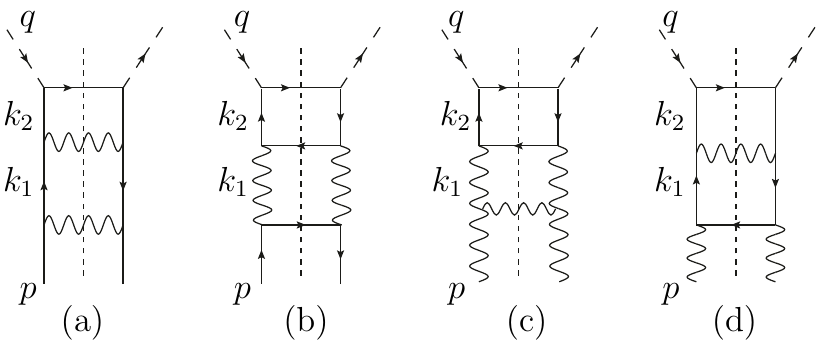
Figure 2 . Ladder graphs for F ( q,g )